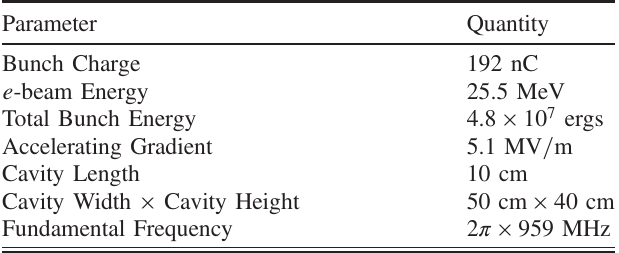
TABLE I. Simulation parameters for testing the algorithm. Parameter